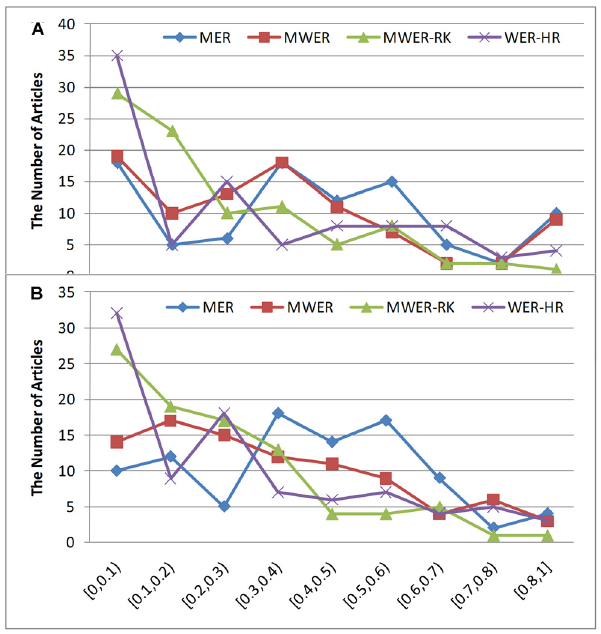
Figure 2. Number of articles as a function of the error rate based on different metrics. ‘‘A’’ for the best similarity based system FIGtext – ATCabstract and ‘‘B’’ for the best frequency based system WFreqRDAbs .